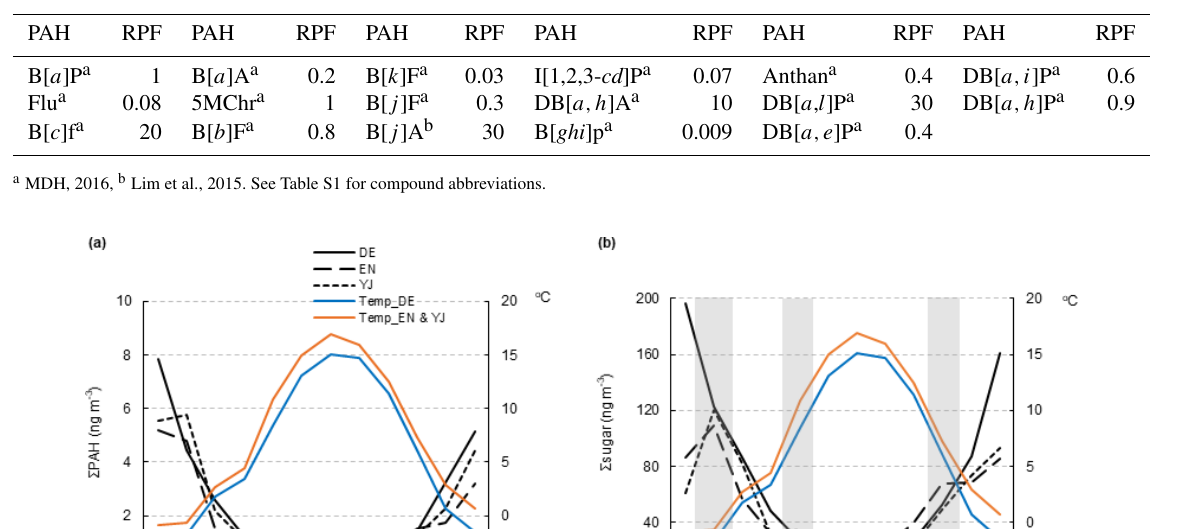
Table 1. The relative potency factor (RPF) for PAHs used in this study.